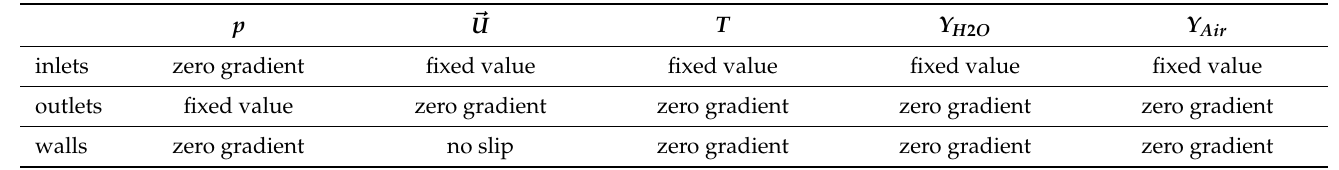
Table 3. Boundary conditions for the simulation of the hollow fibre membrane